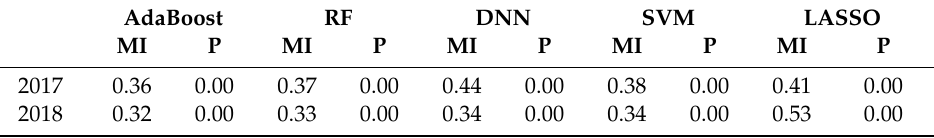
Table 3. Moran's I of the prediction errors from different models (MI: Moran's I; P: P-value). Table 3. Moran’s I of the prediction errors from di ff erent models (MI: Moran’s I; P: P-value).